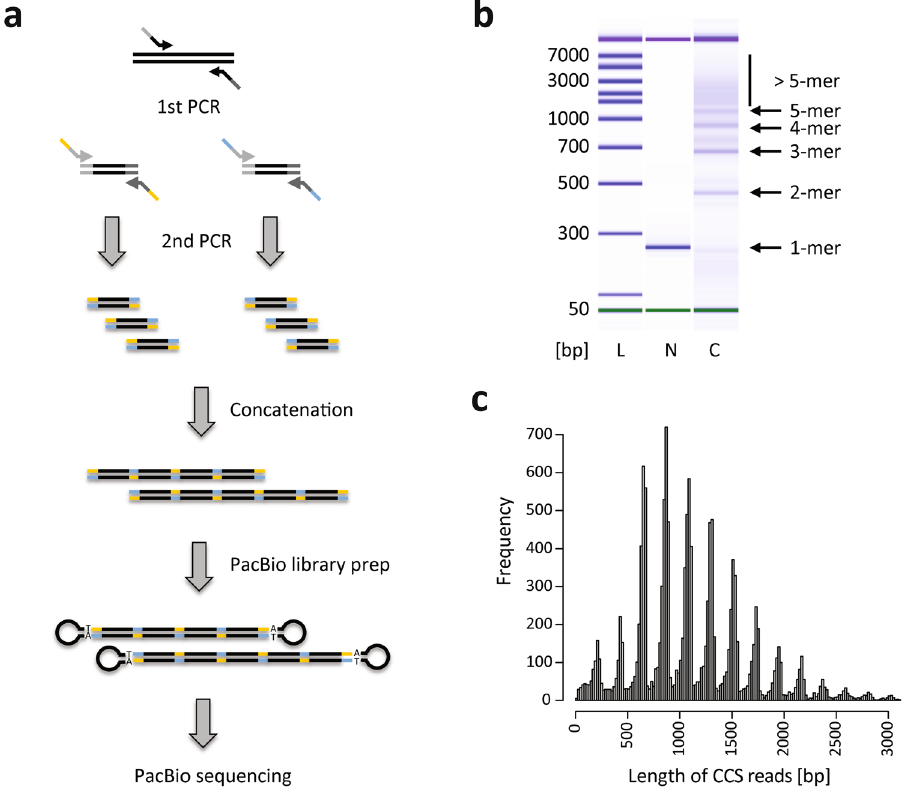
Figure 1. Gibson Assembly concatenates short DNA amplicons into long concatemers. ( a ) Schematic of the ConcatSeq sample preparation workflow for PacBio sequencing. A target amplicon is generated by PCR using primers flanked with spacer sequences (gray portions). These products are then used for a second round of PCR, where in two separate reactions, two different primer sets are used to incorporate complementary Gibson Assembly-compatible adapters to the target molecules (blue and yellow portions). Portions depicted in blue are the reverse complement of those depicted in yellow. The two amplicon pools are then mixed at equimolar quantities and incubated with an enzyme master mix that carries out the Gibson Assembly to generate a pool of concatemers of various lengths and randomized composition. Concatenation is followed by library preparation that attaches PacBio-specific hairpin adapters via A-tailed ligation and subsequent sequencing on a PacBio RSII instrument. ( b ) Bioanalyzer DNA7500 gel image showing ladder [L], the non-concatenated amplicon pool [N], and the concatenated sample [C]. Banding pattern in the concatenated sample indicates depletion of monomers and accumulation of n-mers of higher degree. The expected size of n-mers created this way corresponds to (n * x) − ((n − 1) * y) where x is the size of a monomer and y is the size of the adapter. As in the example shown here the size of a monomer is 247 bp, the expected sizes are: 464, 681, 898, 1115, 1332, and 1549 bp for 2- to 7-mers. ( c ) Histogram of the length of PacBio circular consensus sequences (CCS reads) of the concatenated sample. Peaks coincide with the expected sizes of n-mers. For clarity, the histogram was truncated at 3